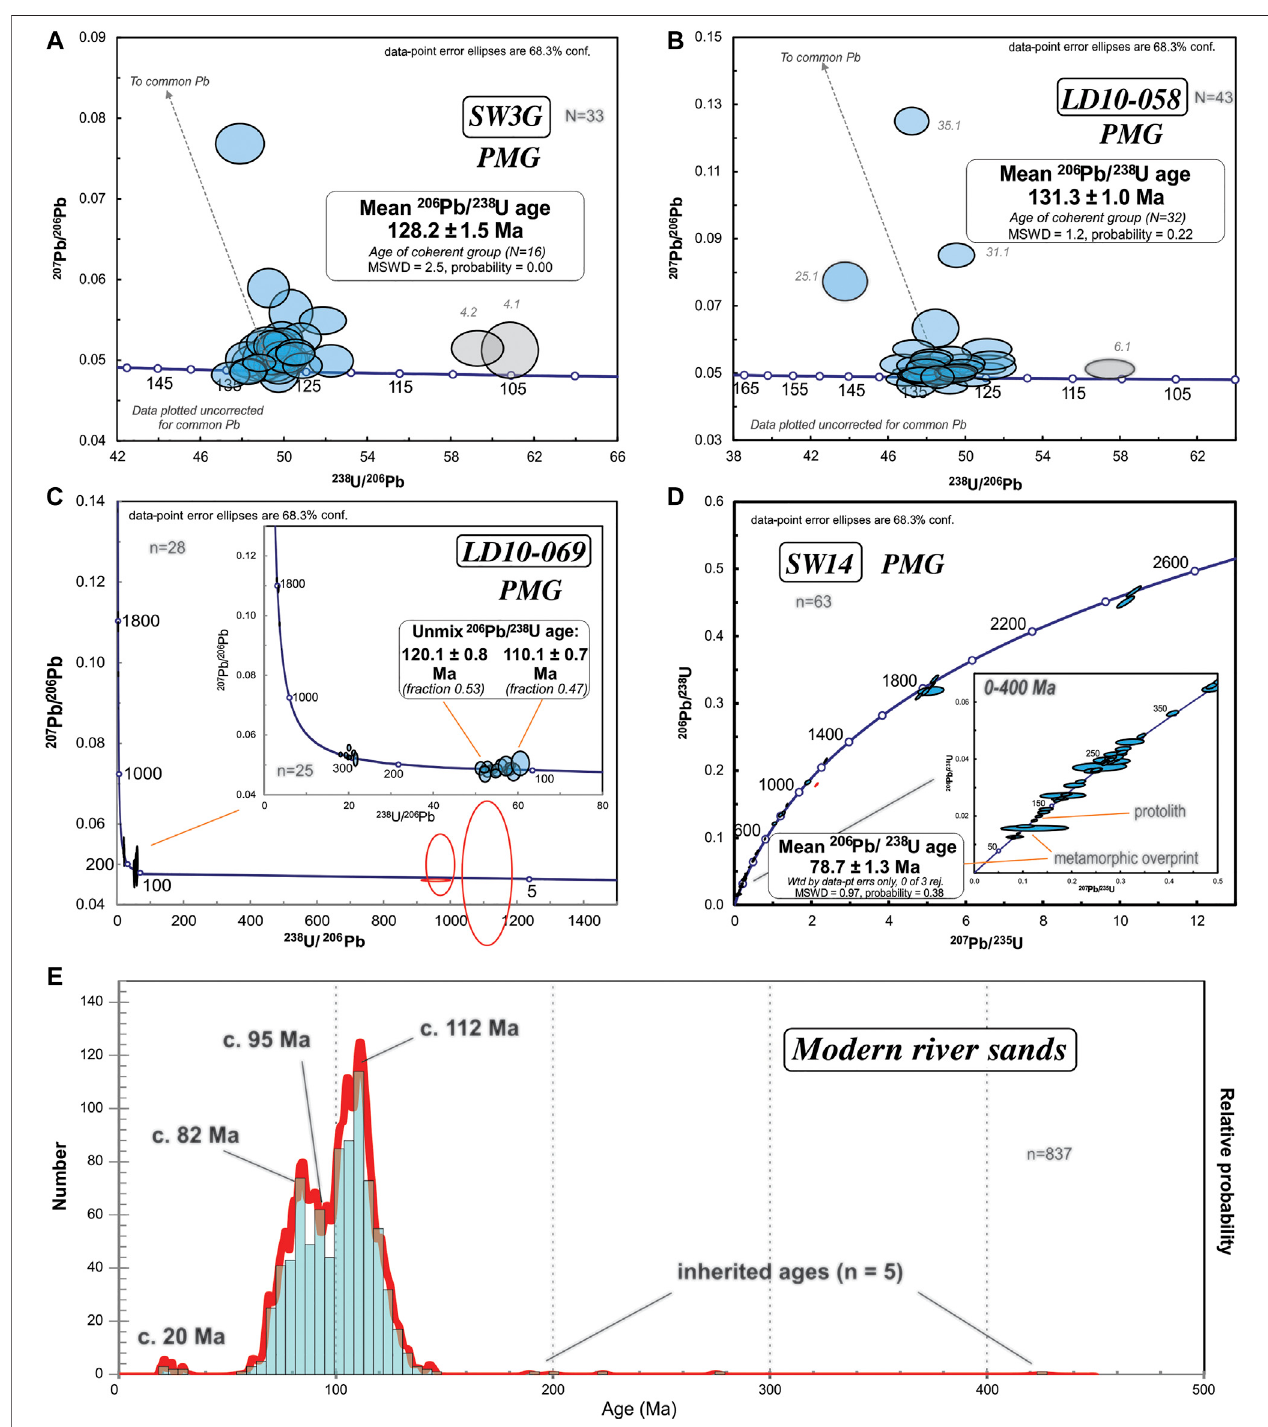
FIGURE 7 | Zircon U-Pb weighted mean age calculation, Tera-Wasserburg diagrams for metamorphic rocks from the Pinoh MetamorphicGroup (continued), and concordia plots and age histogram for metamorphic rocks from the PMG with inherited ages. SHRIMP diagrams display ages uncorrected for common Pb. (A) Terra- Wasserburg plot for SW3G with weighted mean age calculation. (B) Terra-Wasserburg plot for LD10-058 with weighted mean age calculation. (C) Tera-Wasserburg diagram for sample LD10-069 from the Pinoh Metamorphic Group. Two main age cluster calculated with the unmix function of Isoplot. Ages are plotted corrected for common Pb. (D) Conventional concordia diagram for sample SW14 from the Pinoh Metamorphic Group to display the abundant inherited ages. (E) Detrital zircon U-Pb histogram and probability density from modern river sand samples. Main population peaks at c. 112 Ma, 95 Ma, 82 Ma, and at c. 20 Ma.